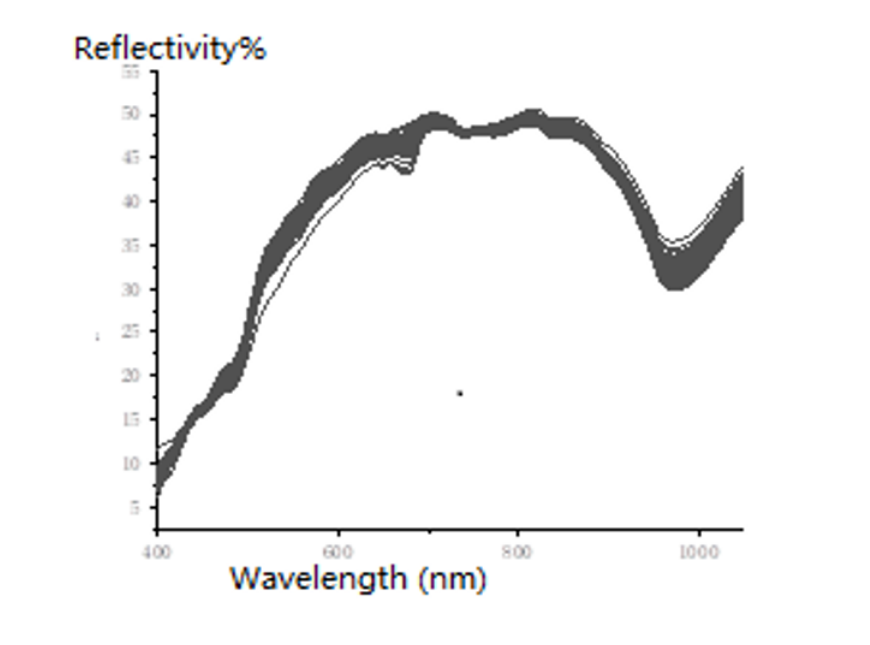
Fig. 1. Original spectral